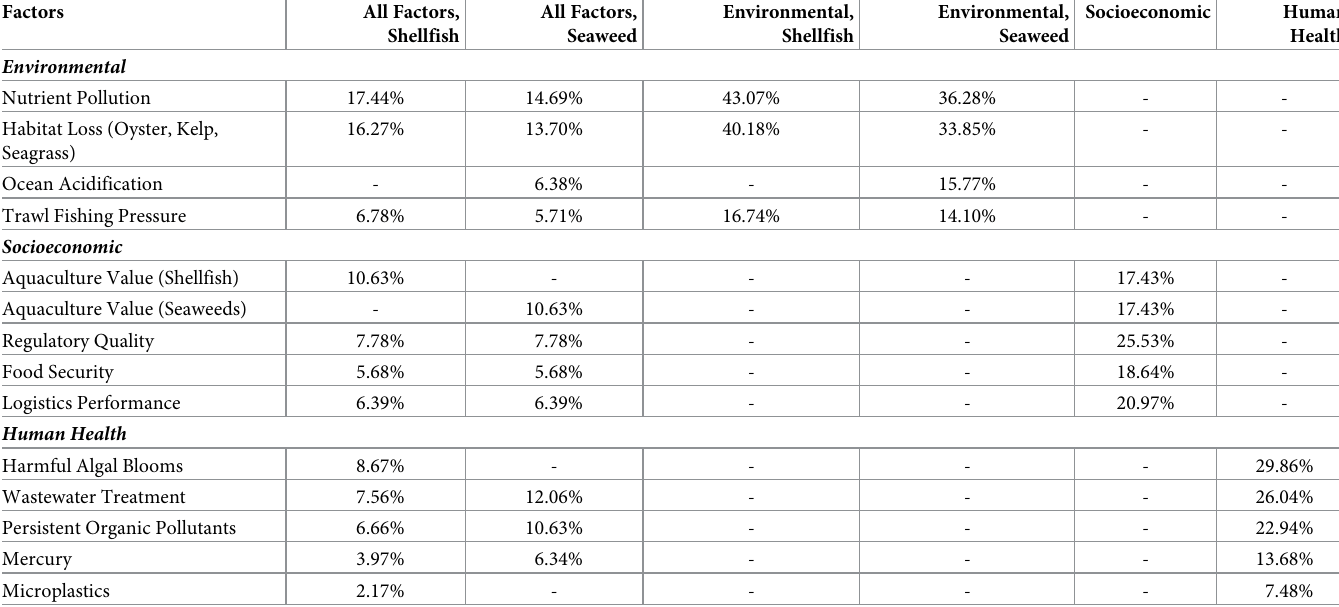
Table 2. Factors and associated weights utilized to compute the restorative aquaculture opportunity index (RAOI) in the six analysis scenarios. Weights were applied to each factor, and the assigned weight corresponds to the relative importance of each factor in determining high opportunity marine ecoregions for shellfish and/ or seaweed restorative aquaculture development in a given analysis scenario. Note that for habitat loss, the indicated weight was divided across all three habitat types (oys- ter, kelp, and seagrass). The assigned weight of all factors in each scenario sum to